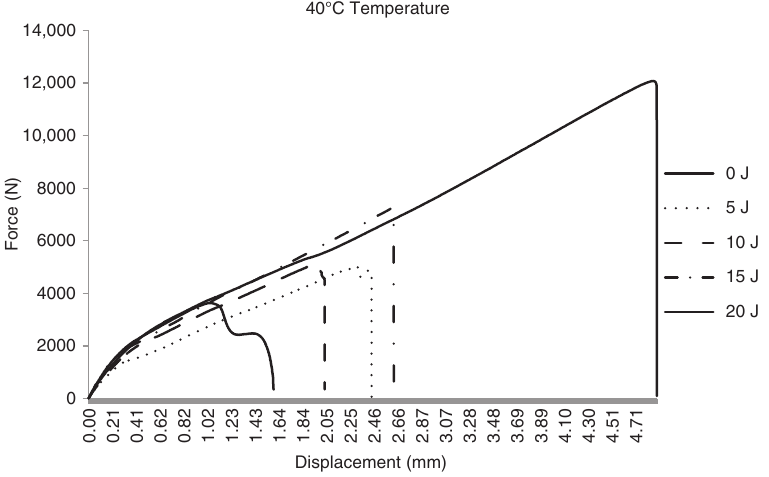
Figure 7: Effects of different impact energy values on load-displacement response at the 40 ° C temperature level.